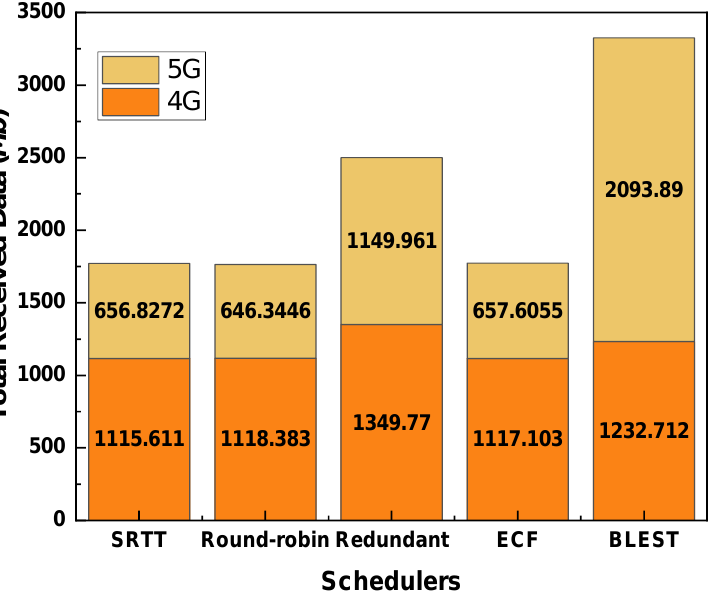
Figure 8. Performance of the tested MPTCP schedulers in terms of total received data for BALIA as a CCA.